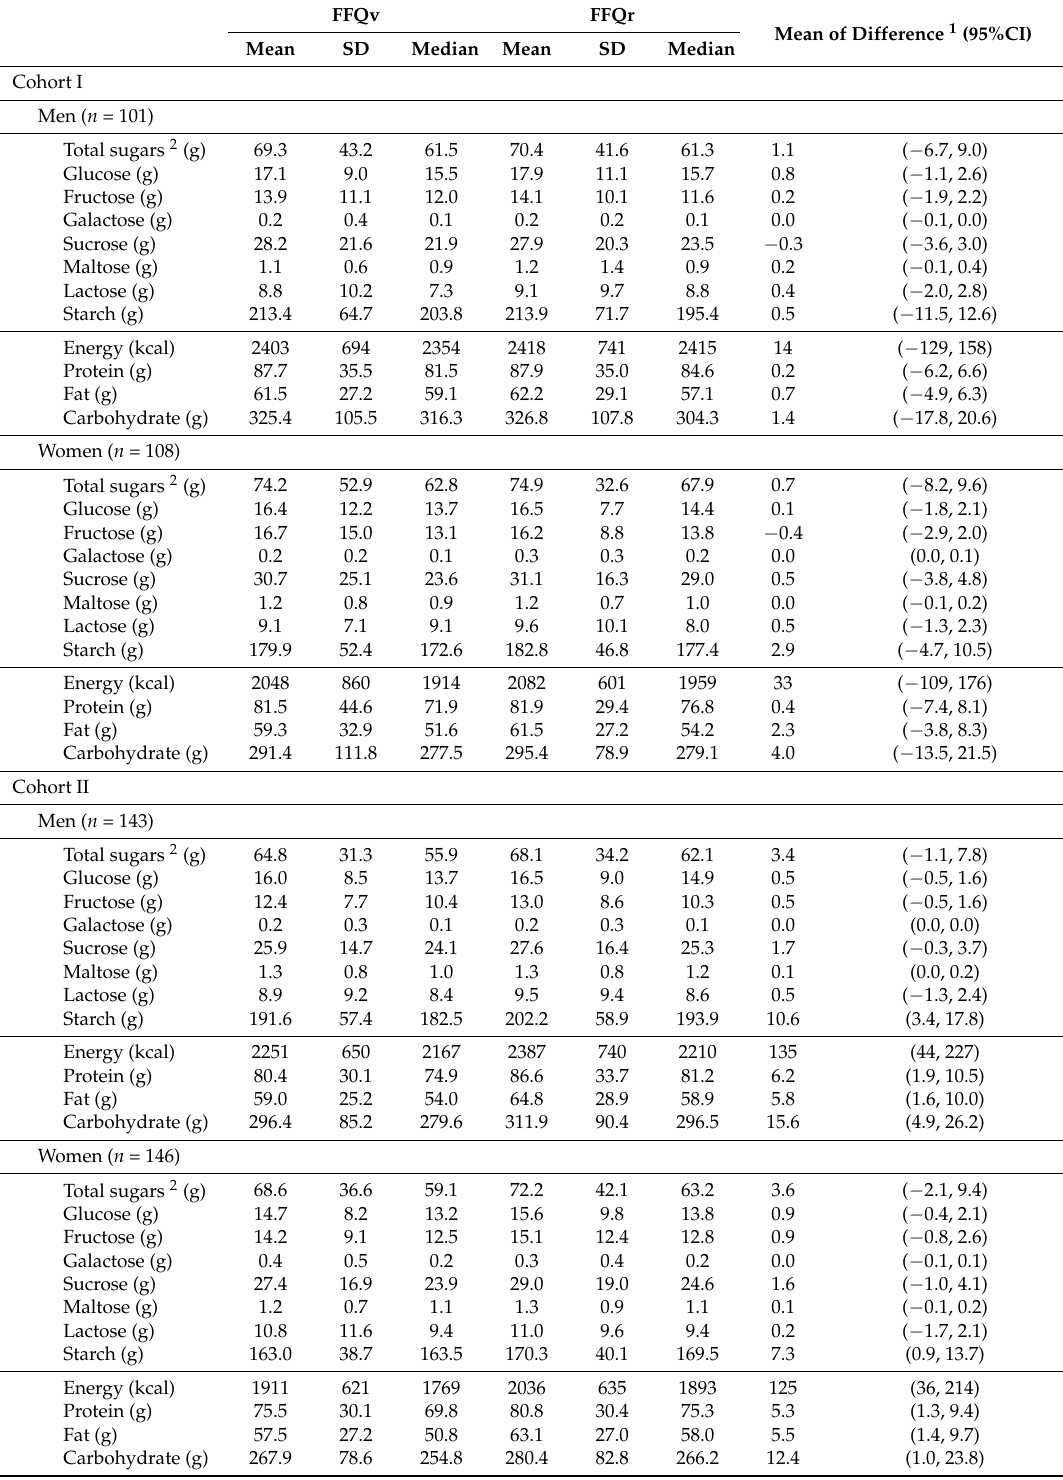
Table 5. Sugar intakes assessed with FFQv and FFQr in Cohorts I and II and differences. FFQv FFQr Mean of Difference 1 (95%CI) Mean SD Median Mean SD